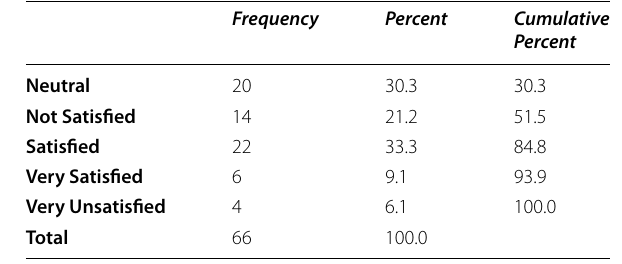
Table 3 Will the implementation of smart solutions in